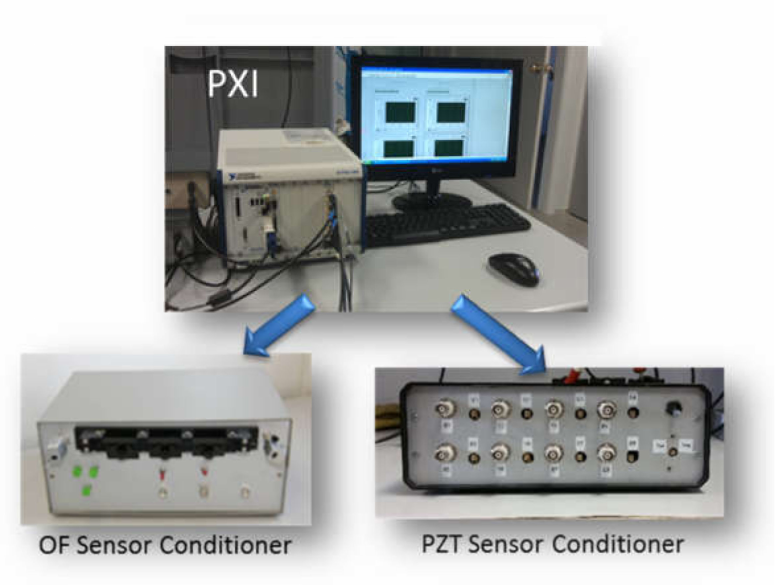
Figure 2. Multichannel acquisition and conditioning